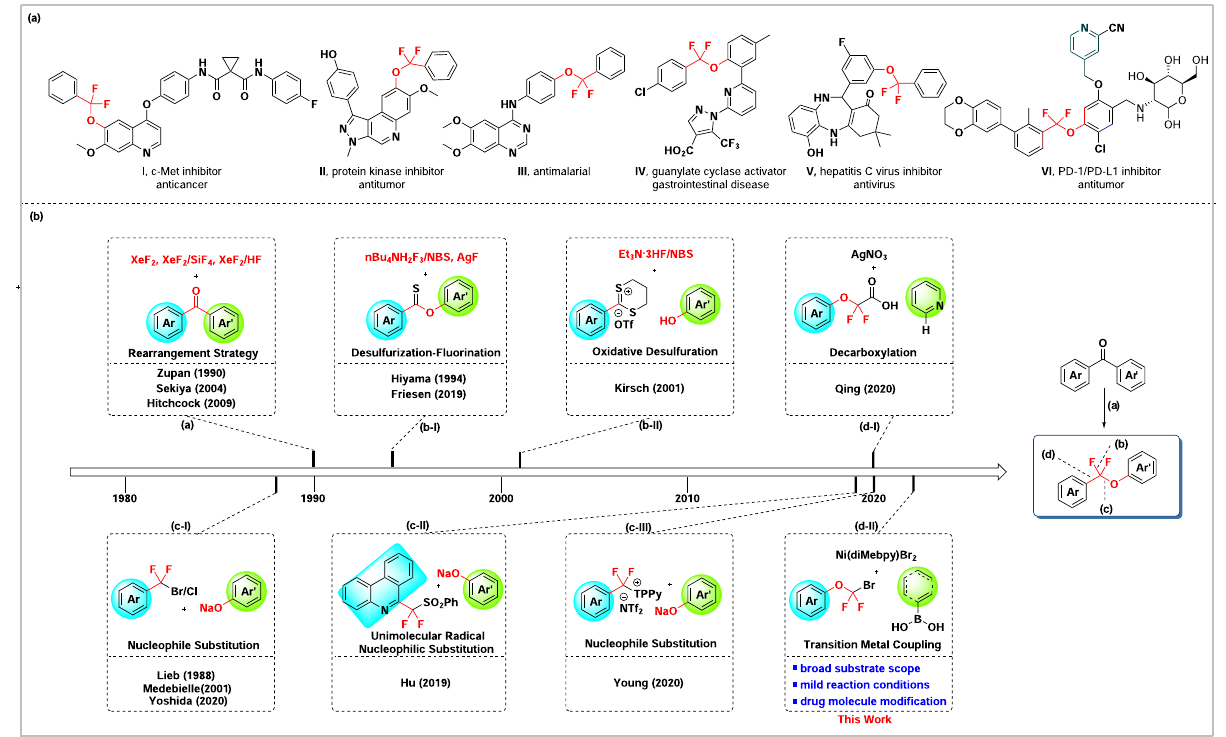
Fig. 1 Overview of methods to prepare aryl aryloxydi fl uoromethyl ethers. a Examples of biologically active aryl aryloxydi fl uoromethyl ethers. b Synthetic methods for aryl aryloxydi fl uoromethyl